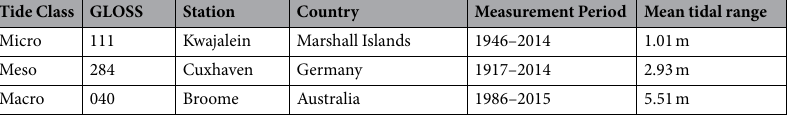
Table 4. Selection of tide gauge stations from the GLOSS Delayed Mode Higher Frequency dataset that signify micro, meso and macro tidal